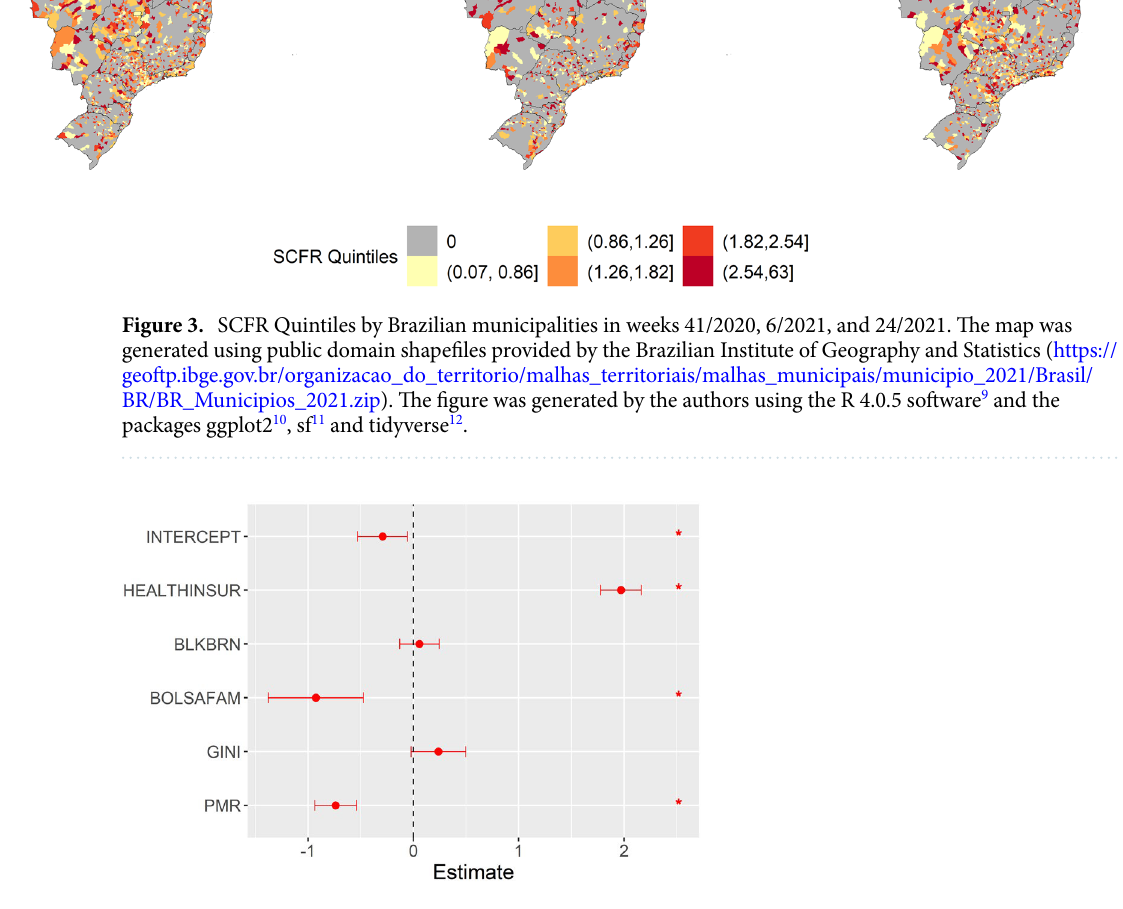
Figure 4. Results of the ZINB spatial–temporal regression model for the standardised incidence ratio of severe acute respiratory syndrome coronavirus